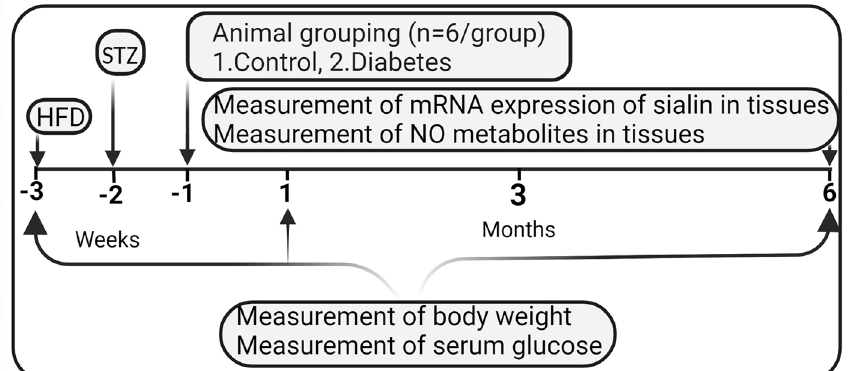
Figure 1. Experimental design of the study. HFD high fat diet, STZ streptozotocin, NO nitric